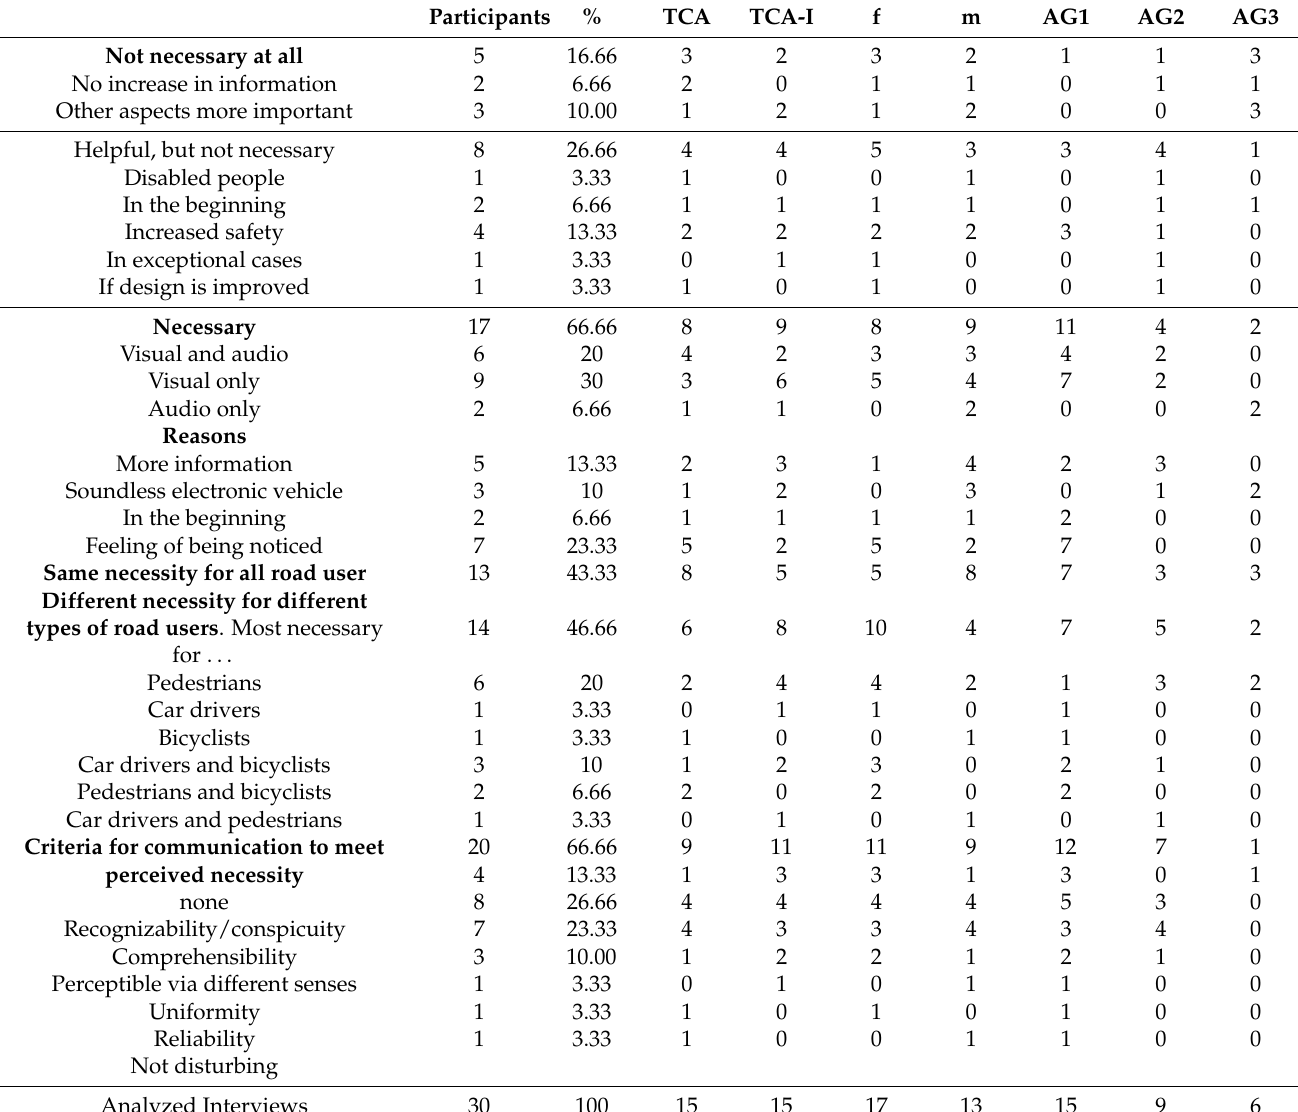
Table A4. Perceived Necessity of External Communication in Automated